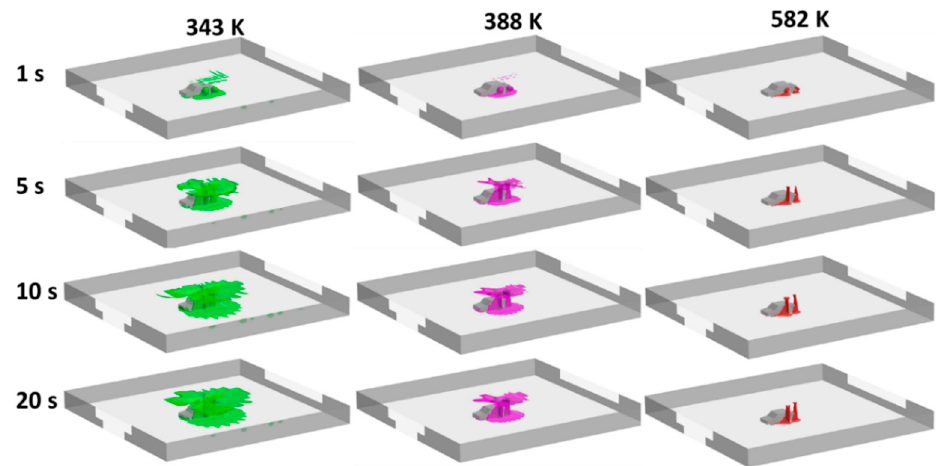
Figure 12. Iso-surfaces showing no-harm (343 K), pain (388 K) and fatality (582 K) temperature limits for ignited hydrogen release in case 9 (TPRD = 0.5 mm, 0° angle downward release with tank blow- down and car body).